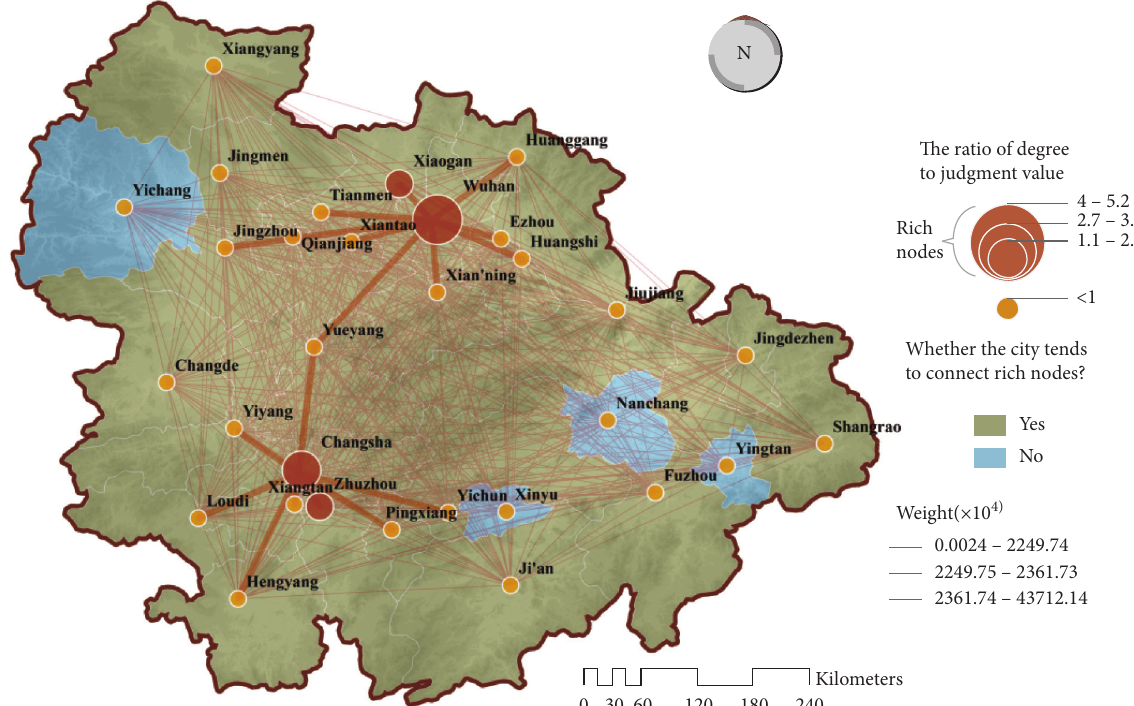
Figure 7: “Rich-club” cities in the CO 2 emission network and local rich-club